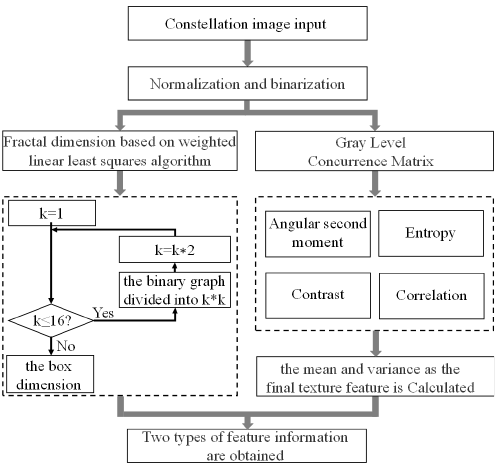
Figure 2. Algorithm flow for extracting signal constellation diagram